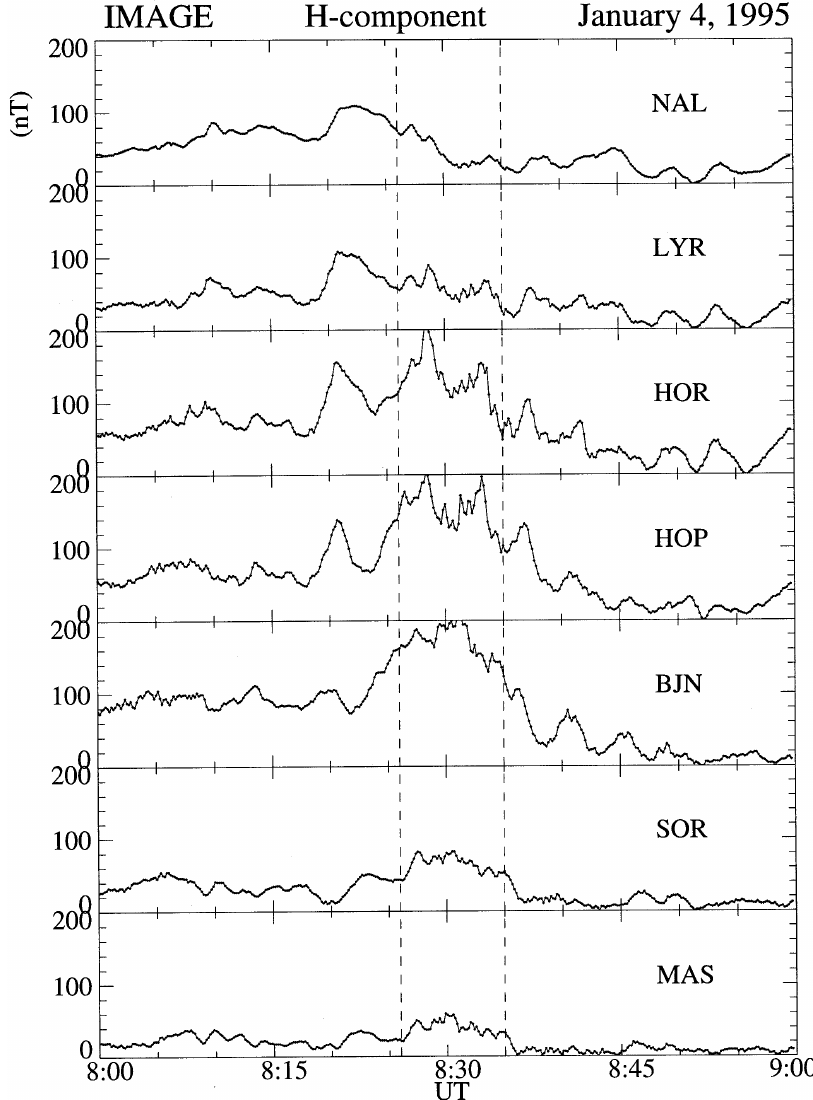
Fig. 3. X component magnetograms from the IMAGE chain stations in NAL (76.1 ◦ MLAT), LYR (75.1 ◦ MLAT), HOR (74.0 ◦ MLAT), HOP (72.9 ◦ MLAT), BJN (71.3 ◦ MLAT), SOR (67.2 ◦ MLAT), and MAS (66.1 ◦ MLAT) for the interval 08:00–09:00UT. The enhanced disturbance (convection bay), maximizing at BJN-HOP during 08:26–08:35UT, is delimited by vertical